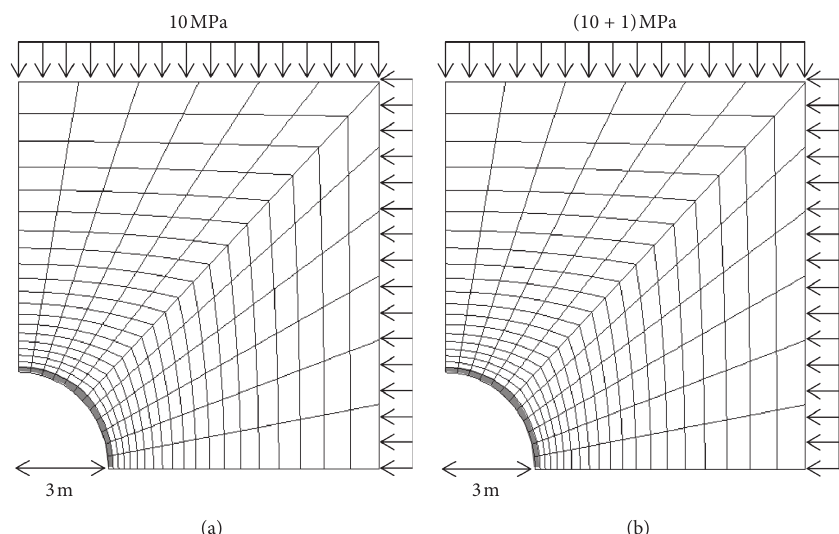
Figure 6: Numerical model for back analysis based on the modified DEA using stress and displacement. (a) Segment-lined tunnel under